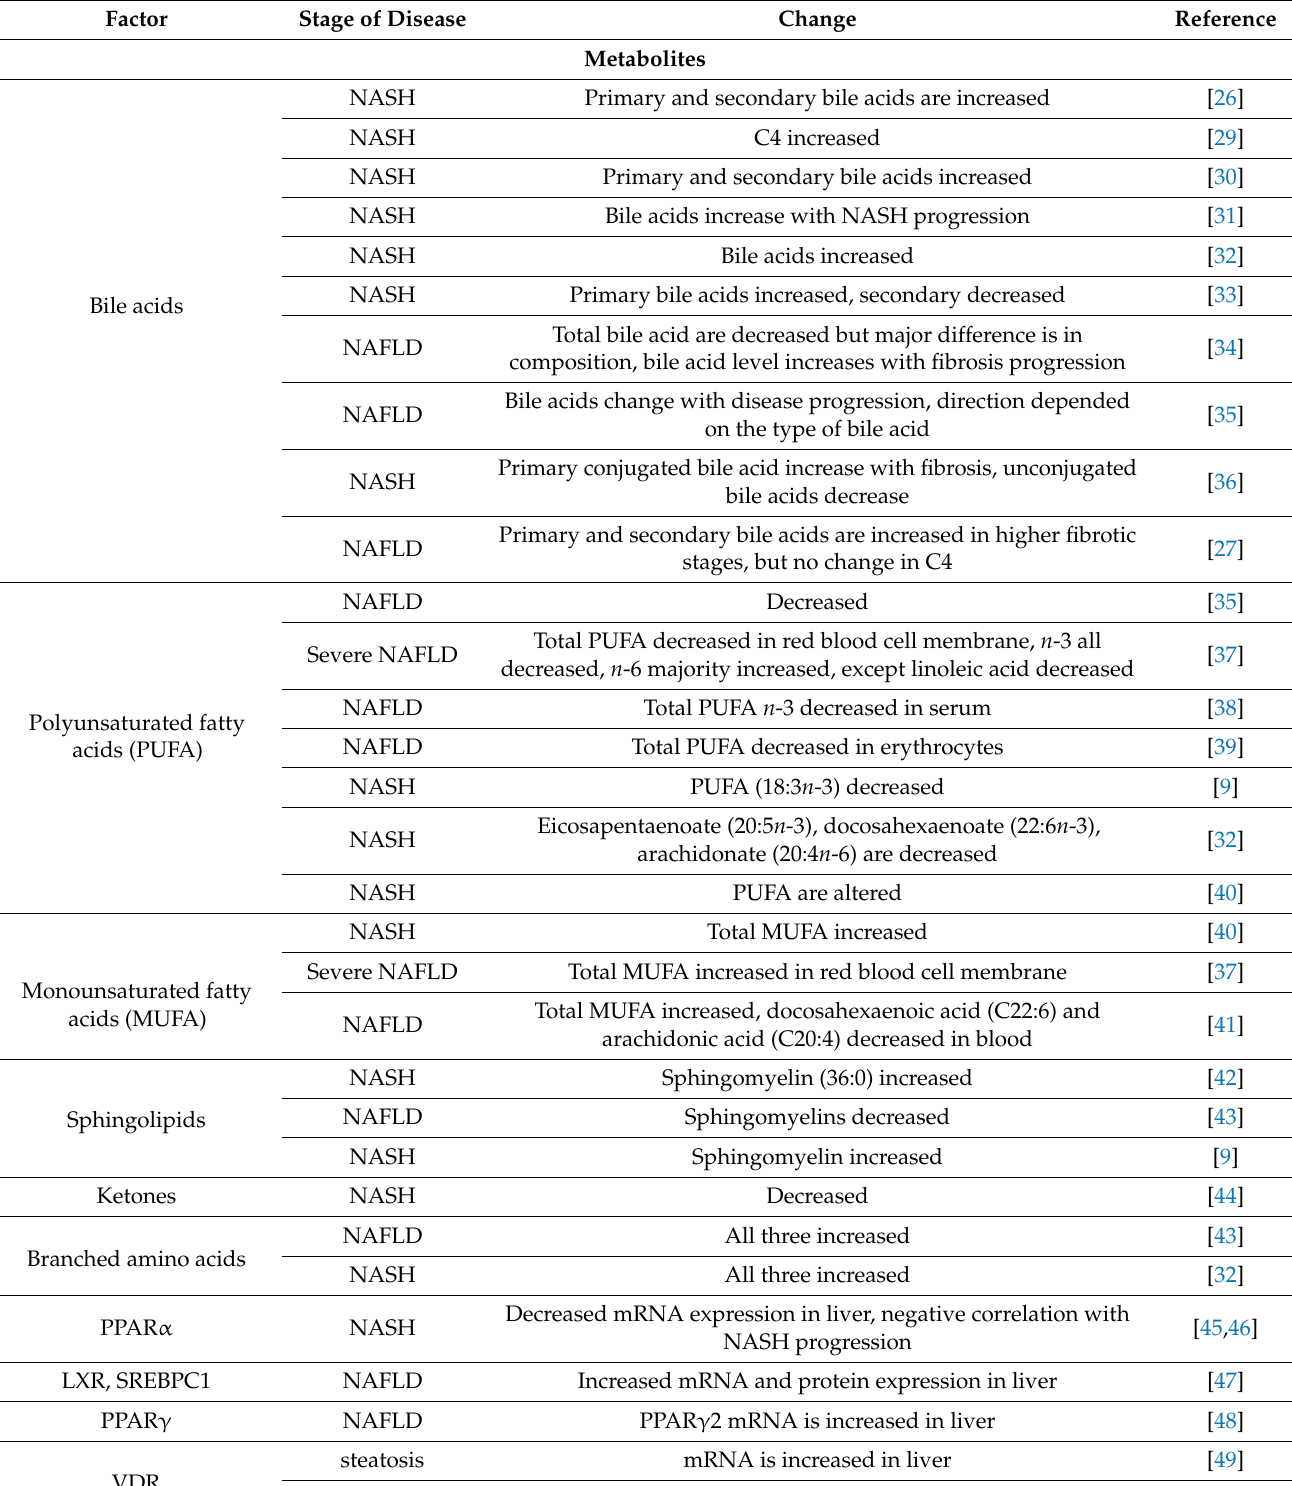
Table 3. Overview of changes in the level of serum metabolites and in the liver expression of transcription factors in humans with NAFLD and NASH. Selected were metabolites and TFs, which were exposed as key factors in the fibrotic program by genetic mouse models of liver fibrosis. C4: